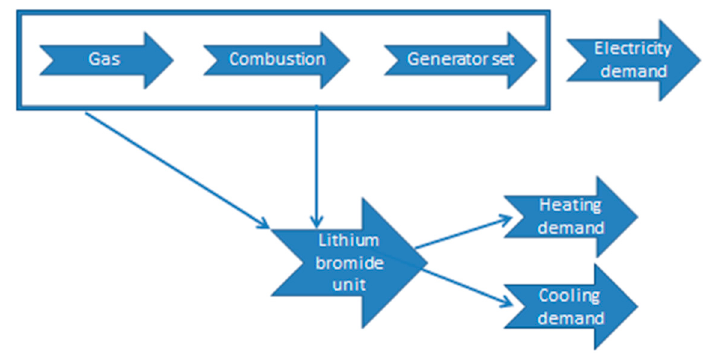
Figure 1. Typical natural gas distributed generation system.